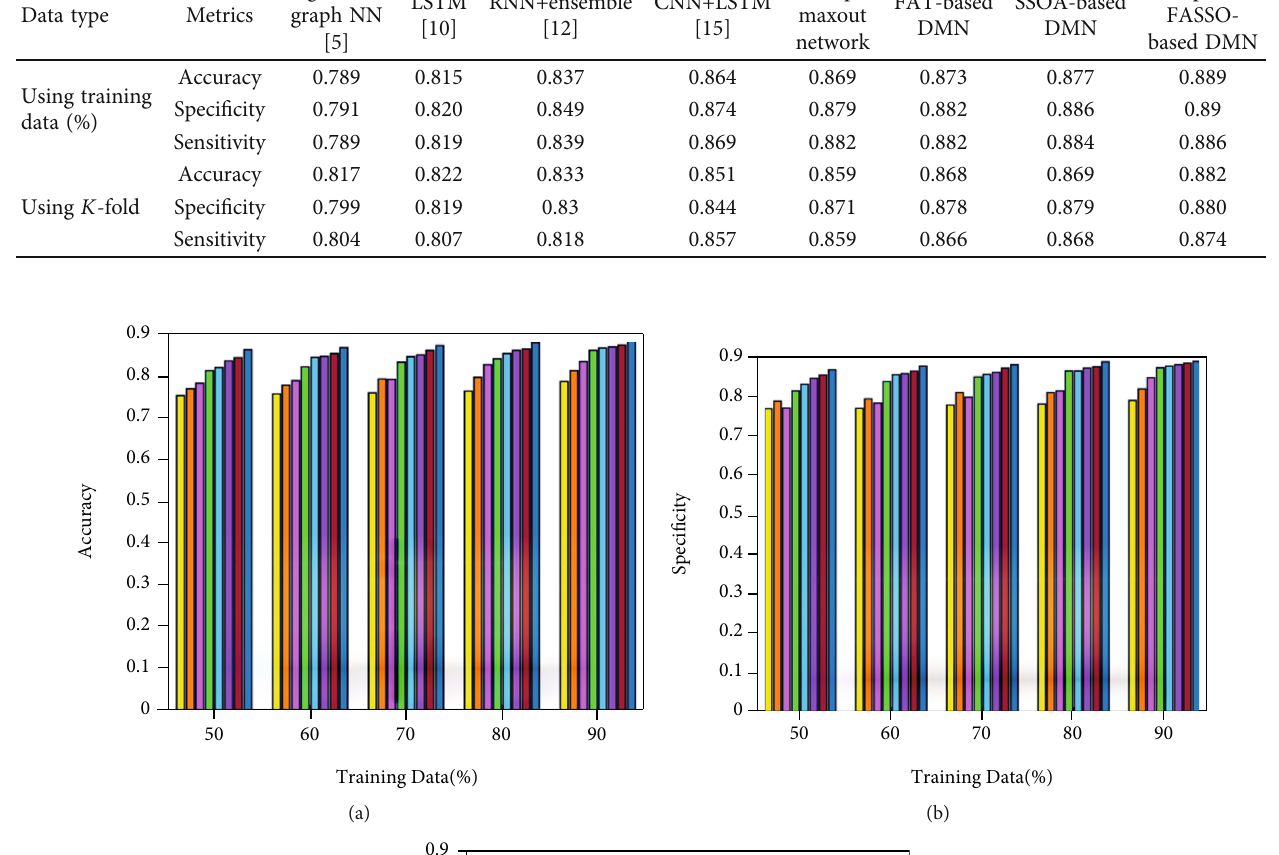
Table 1: Comparison of the proposed method with the existing techniques using training data and the k -fold. Data